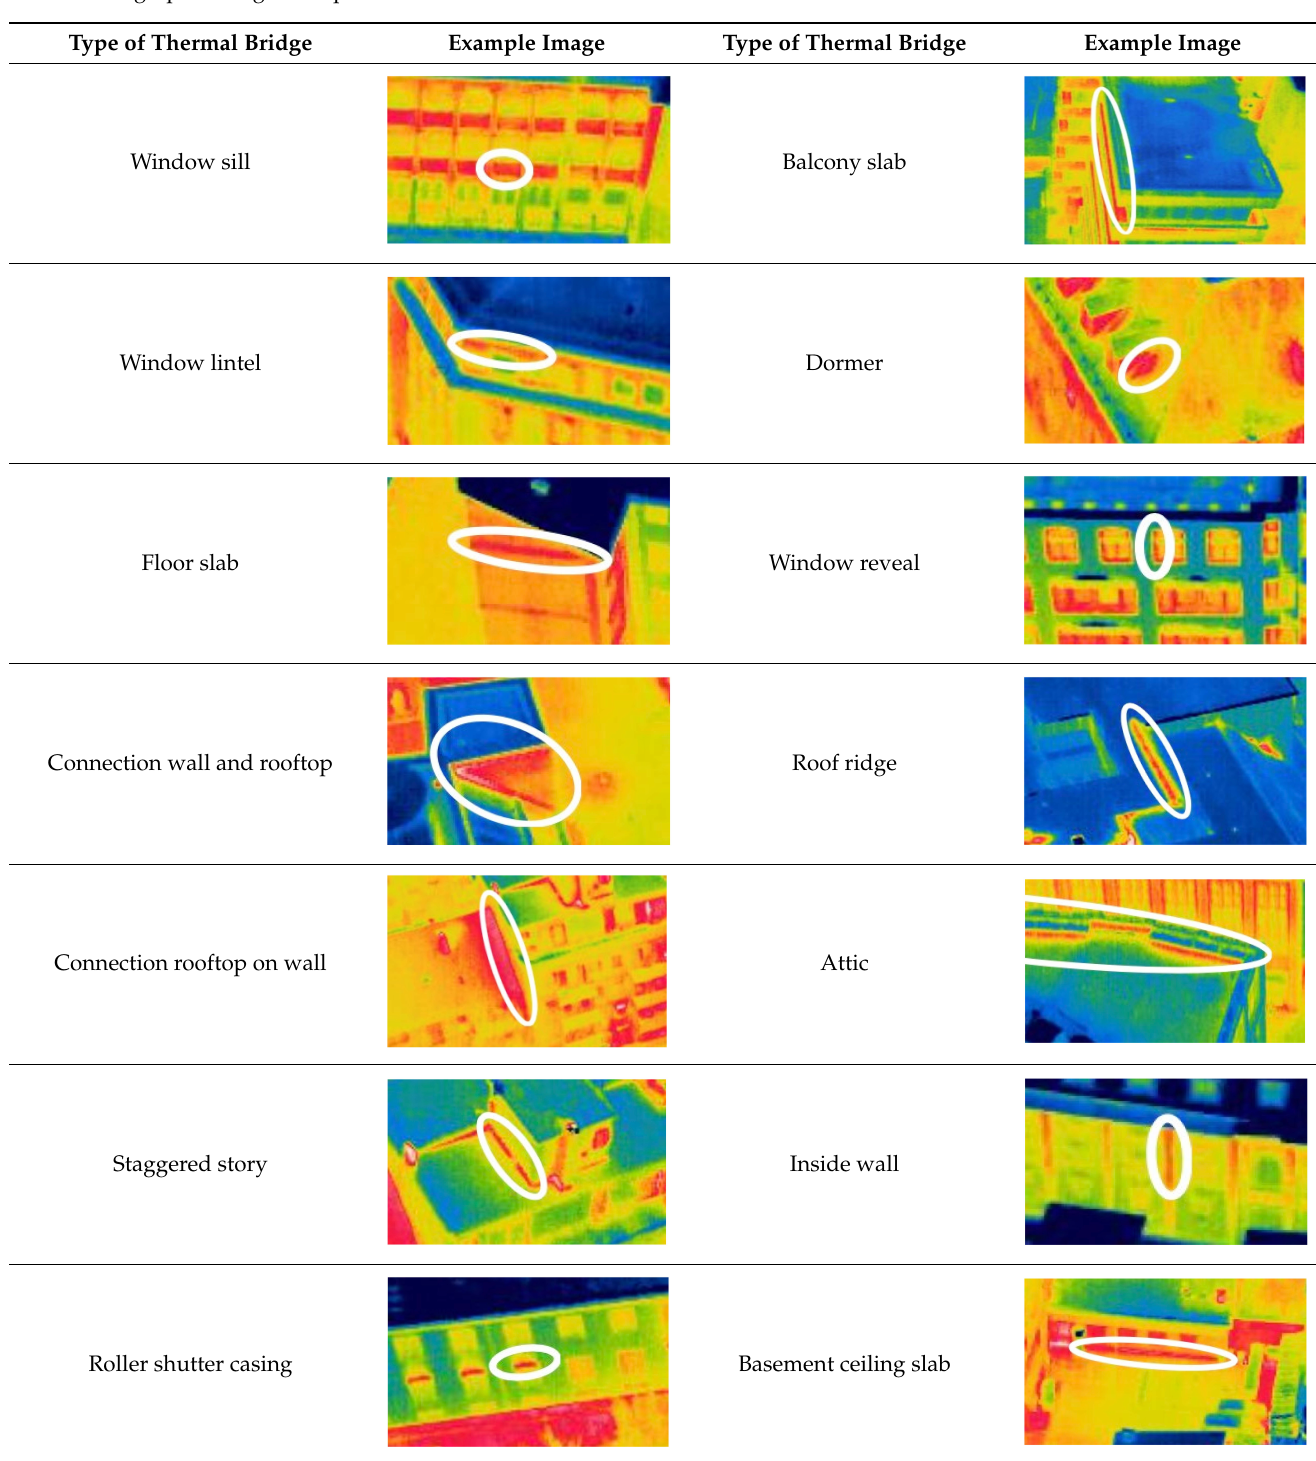
Table 2. Overview of 14 thermal bridge types of German buildings constructed in the time between 1950 and 1969 with thermographic image